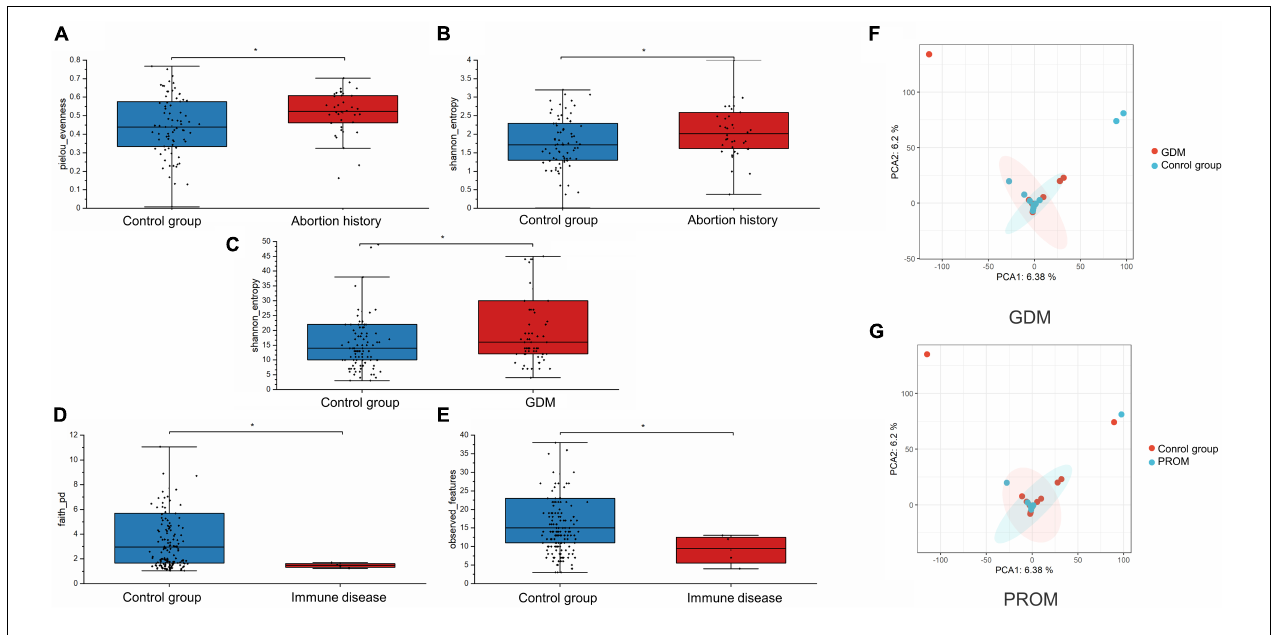
FIGURE 1 | Alpha-diversity was displayed in abortion history [pielou_evenness ( A , P = 0.027) and Shannon_entropy ( B , P = 0.014)], GDM [Shannon_entropy ( C , P = 0.035)], and immune disease [Faith_PD ( D , P = 0.024] and Observed_features ( E , P = 0.044) groups. PCA analysis of neonatal microbiome in GDM ( F , P = 0.709) and PROM ( G , P = 0.865) history groups. * P < 0.05.